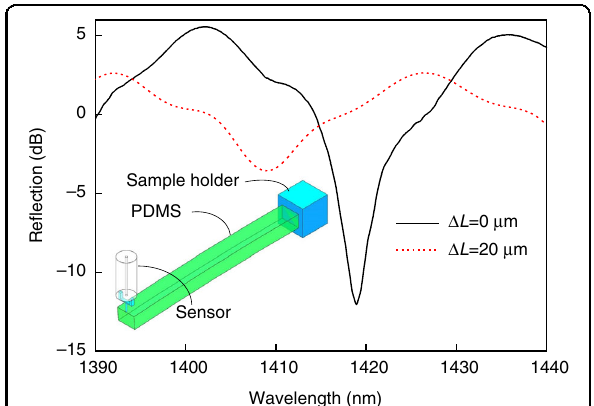
Fig. 6 Evolution of re fl ection spectrum of the sensor as PDMS de fl ects from 0 to 20 μ m. As shown in the inset, one end of the PDMS sample is fi xed while the other end is de fl ected by the proposed